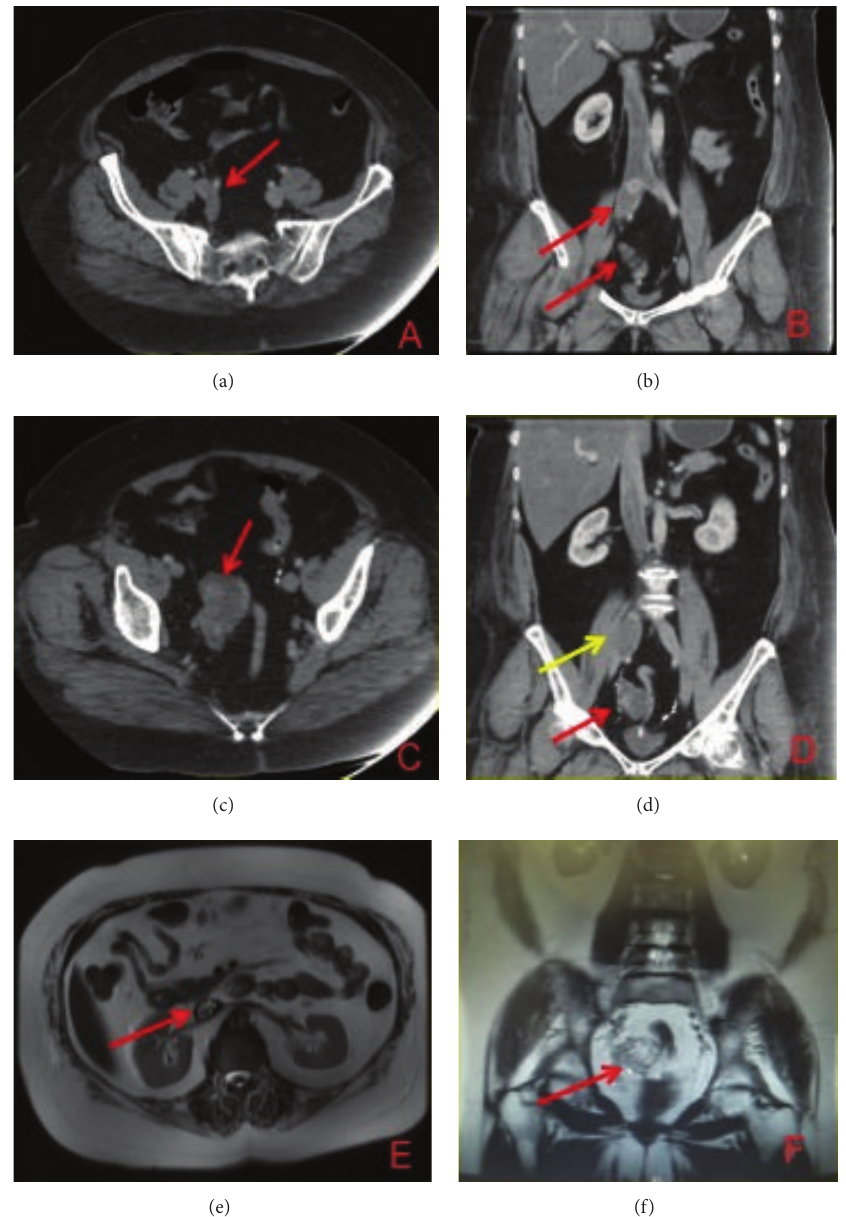
Figure 4: (a) CT axial and (b) coronal views of the IVL in the right common iliac vein (red arrows). (c) Axial and (d) coronal views of the pelvic component of the tumor (red arrows), abutting the dilated common iliac vein (yellow arrow). (e) Axial T2-weighted sequence on MRI identifying the intraluminal caval tumor with (f) associated pelvic mass on coronal